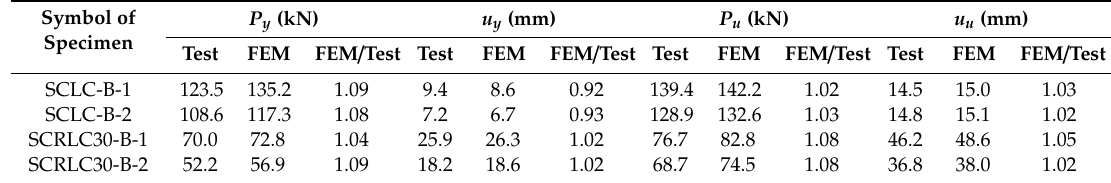
Table 8. Comparison of test and FEA